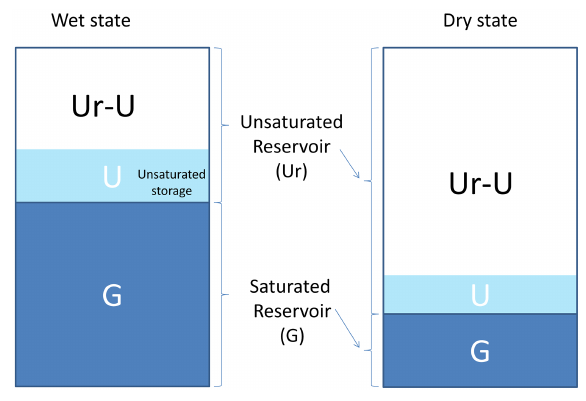
Figure 5. A proposed conceptual model for soil moisture account- ing within rainfall–runoff